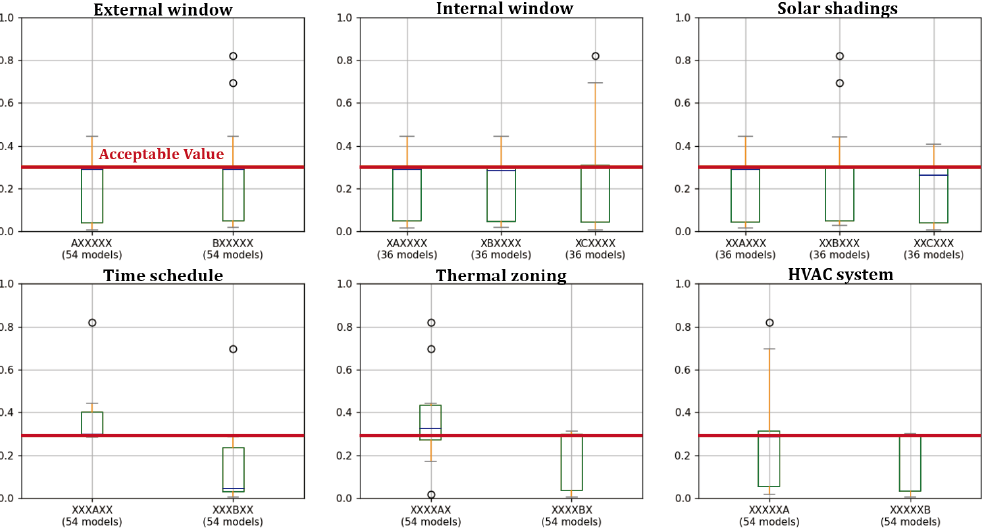
Figure 9. The boxplot of the six input parameters for the building versus the CVRMSE for energy consumption. Table 5. The analysis of U-testing for the CVRMSE boxplot (energy consumption).